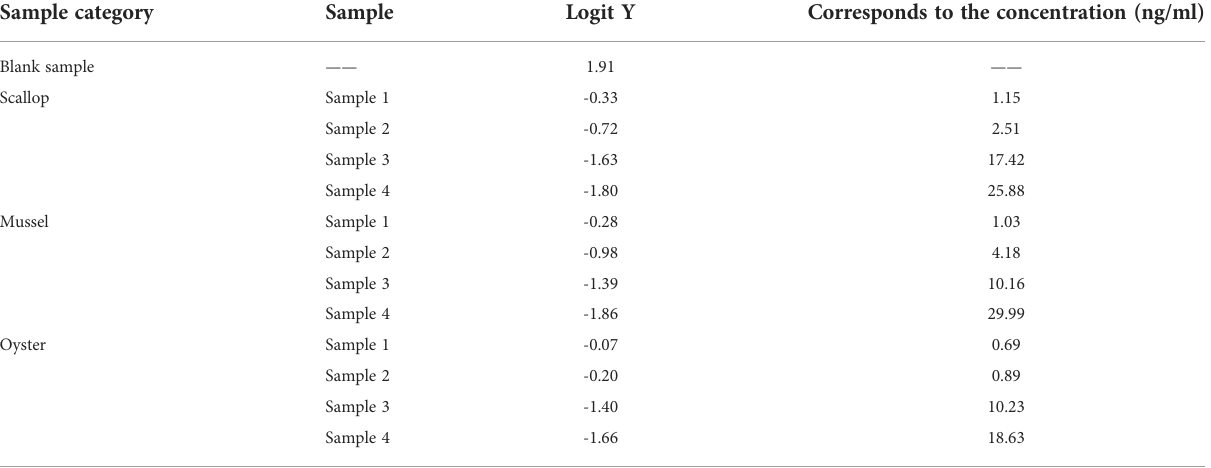
TABLE 2 TRFIA detection of shell fi sh samples.